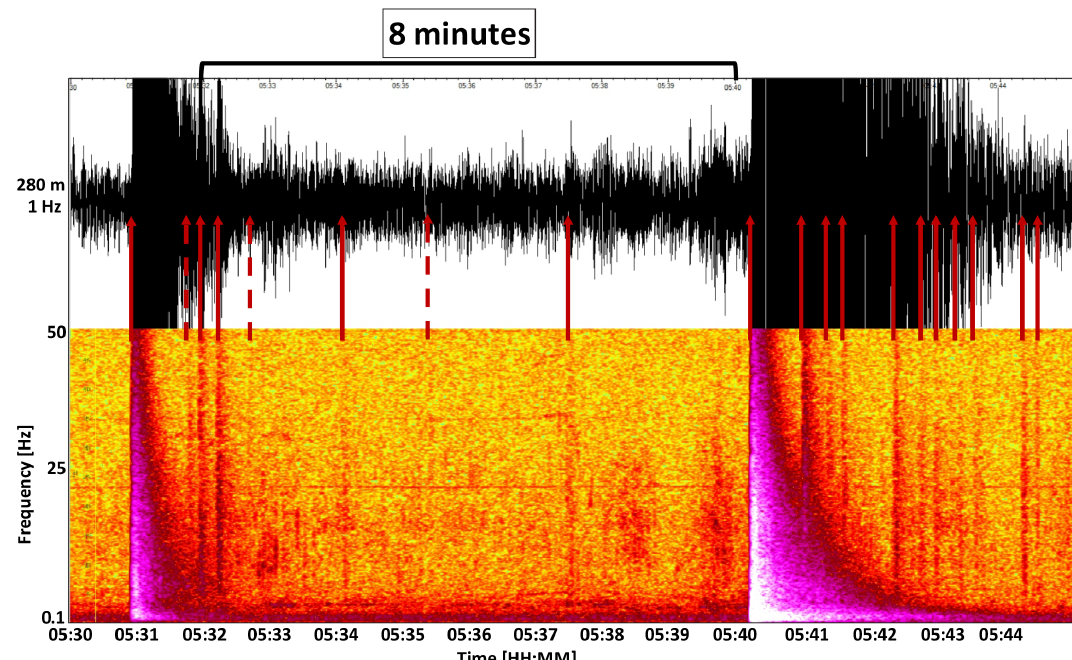
Figure 7. This figure shows the times of earthquakes identified at the ∼ 300m deep 1Hz GONAF-TESV sensor by their spectra in the 15min interval from 05:00:00 to 05:15:00 on 25 June 2016. The solid arrows indicate events with S–P time within 0.1s of the fore- and main-shocks, the latter arriving at 05:30:56 and 05:40:15. The dashed arrows are events that do not have this S–P time or could not be confidently identified and measured in the waveform data